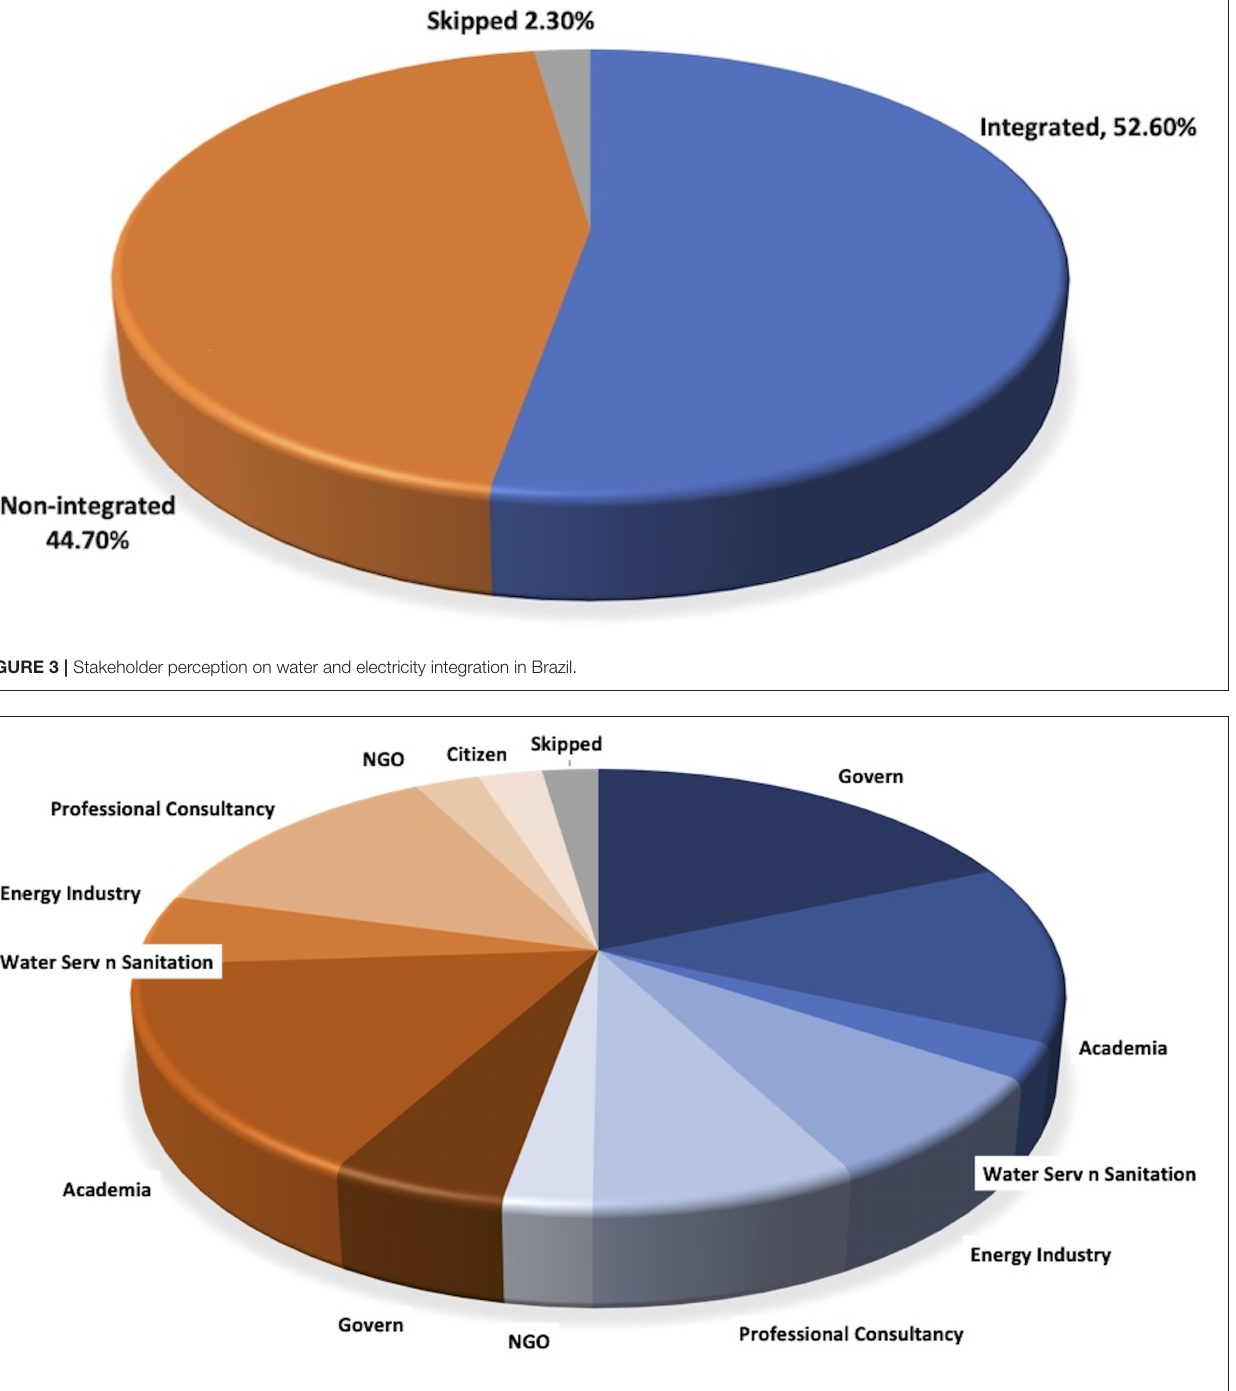
FIGURE 4 | Spread in stakeholder’s views on water and electricity integration in